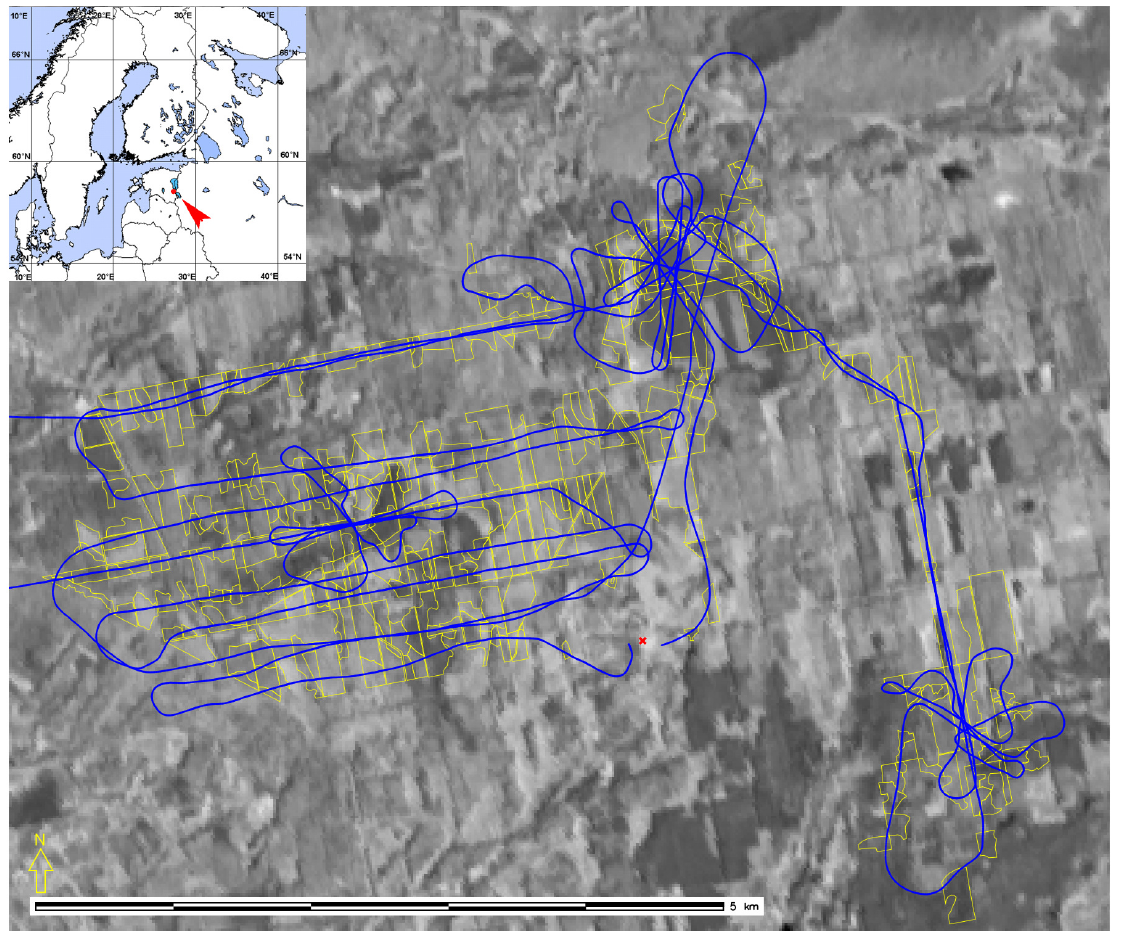
Figure 1. Flight route of helicopter measurements on 5 July 2010, with forest stand borders. The background is the satellite image of Proba/CHRIS scene DD40 band 12 (NIR) of 27 July 2011, at a spatial resolution of 17 m. Yellow polygons mark the stands involved in this study, and the red cross marks the place of incident radiation